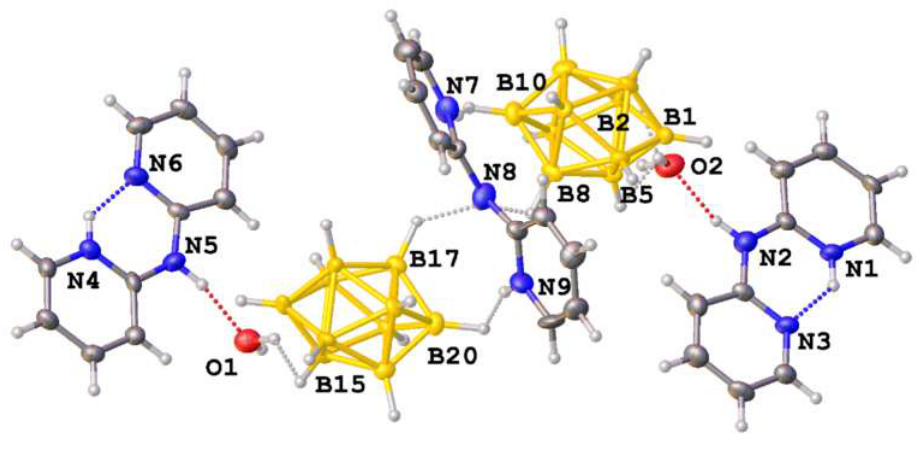
Figure 1. Asymmetric unit of 1 · 2H 2 O in representation of atoms with thermal ellipsoids (p = 50%). H-bonds are depicted with dotted lines.